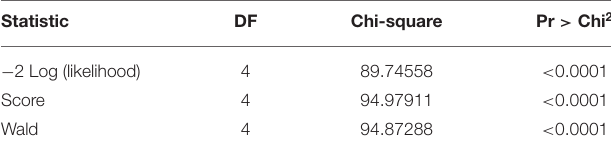
TABLE 8 | Test of the null hypothesis H0: beta =